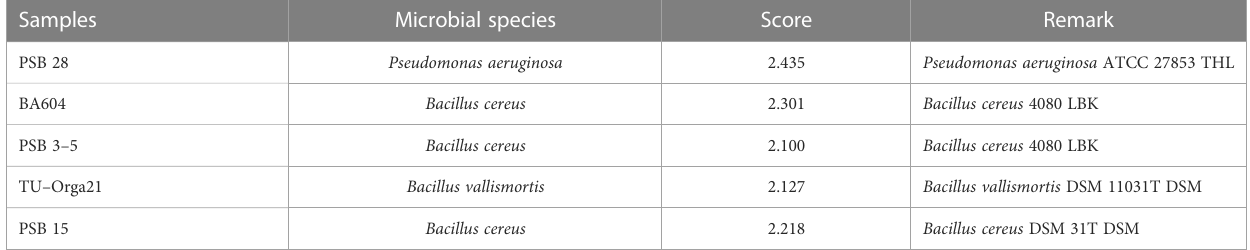
TABLE 1 Microbial species identi fi